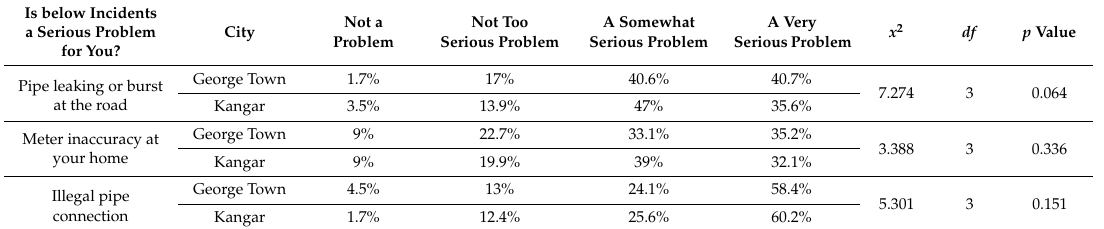
Table 5. Public concern of the water loss issue.